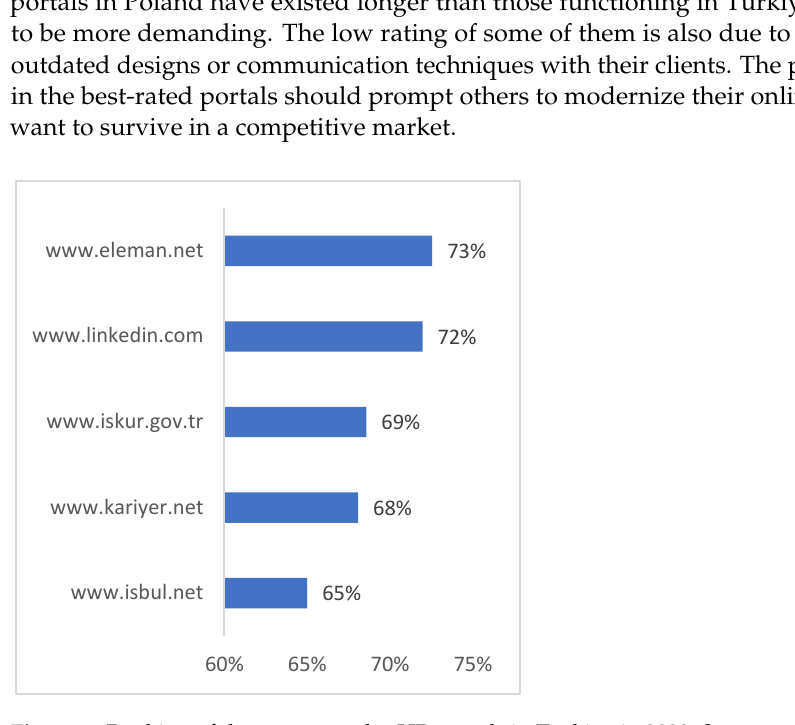
Figure 4. Ranking of the most popular HR portals in Türkiye in 2022; Source: own work.